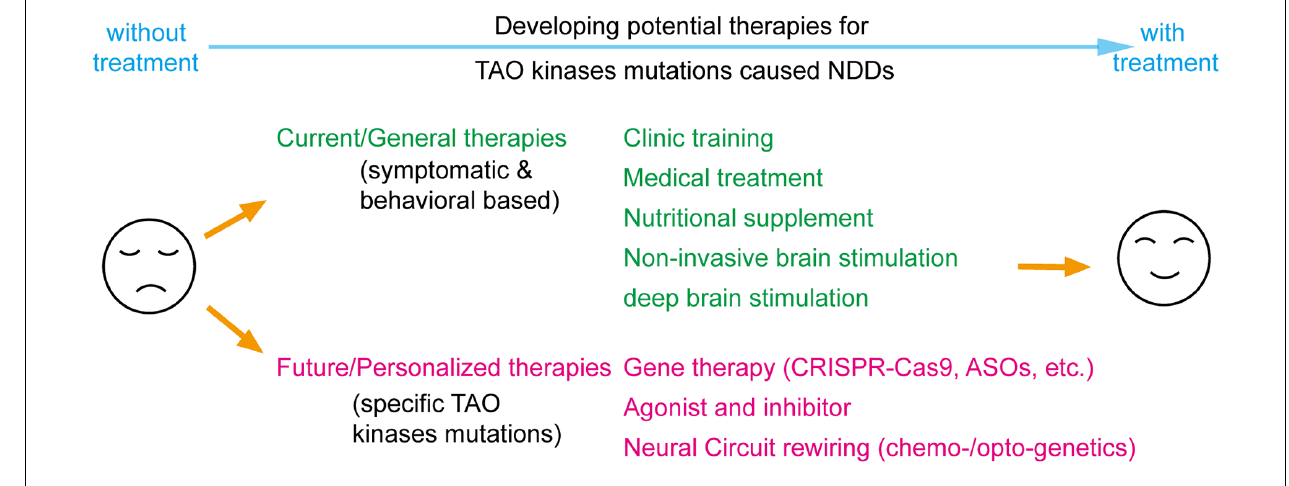
FIGURE 4 | Perspectives on developing potential therapies for TAO kinases mutations caused neurodevelopmental disorders (NDDs). Current therapies include most symptomatic and behavioral based treatments which could be applied to all factors caused NDDs including traditional clinical training, medical treatment, nutritional supplementation, and brain stimulations. With significant progress in biotechnology, the concept for future therapies could focus on personalized therapy by specifically targeting TAO kinase mutations by gene therapy, developing specific agonist or inhibitors and rewiring neural circuits with chemo- or